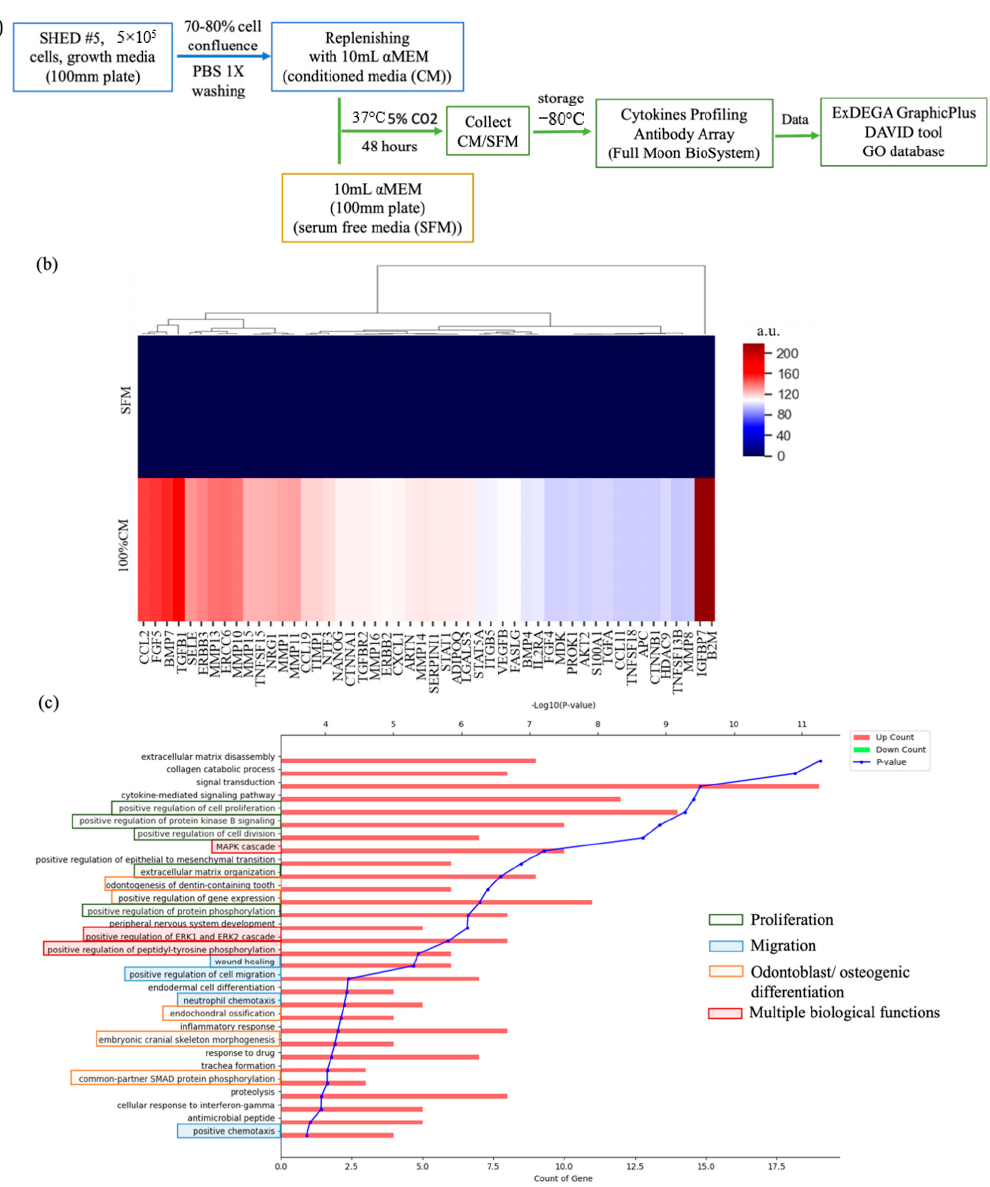
Figure 4. Cytokine profiling array. ( a ) The process of cytokine analysis is briefly described. SHED at the 5th passage achieved 70%–80% confluence and was replenished with serum-free α MEM. After 48 h, the conditioned medium (CM) was collected. Control conditioned media was collected from serum-free α MEM (SFM) under the same conditions as conditioned medium. All CM and SFM were stored at − 80 °C to maintain the biological properties before cytokine antibody analysis. The Fullmoonbio Cytokine Profiling antibody array features 310 antibodies for profiling cytokines, and related biomarkers were used. The data were analyzed with the ExDEGA GraphicPlus and DAVID tools based on the Gene Ontology (GO) database. ( b ) A clustering heatmap based on the 50 top cytokines showed a significant difference between SFM and 100% CM. ( c ) Using the 50 top cytokine lists, the DAVID v6.8 analysis tool with the Gene Ontology Term Biological Process database and ExDEGA Graphic Plus were used to build a functional annotation chart. The graph shows that SHED CM containing growth factors and cytokines has a positive effect on cell proliferation, migration, survival, and osteogenic differentiation. Pathways/biological activities related to upregulation of proliferation, migration, odontoblast/osteogenic differentiation, and multiple biological functions (proliferation, migration, downregulation of cell apoptosis, differentiation including downregulation of cell apoptosis) are marked in different colored boxes (green, blue, orange, and red,